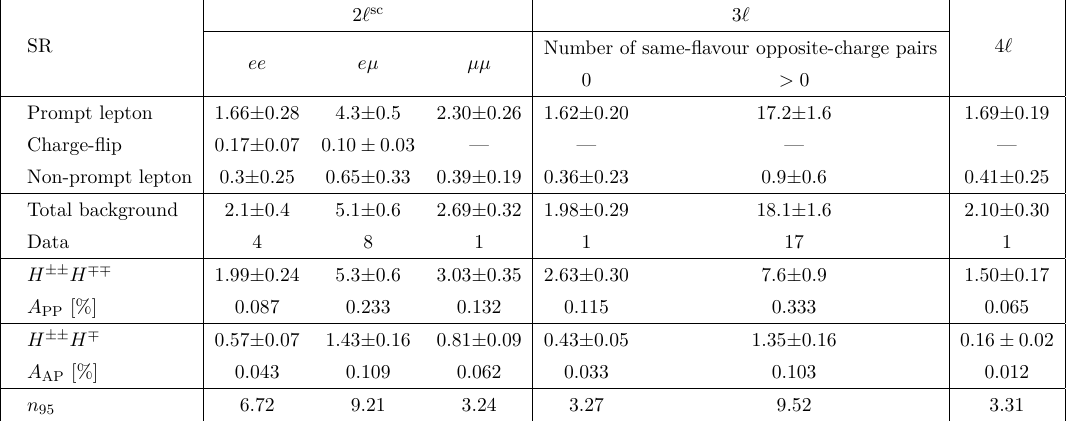
and A and the observed upper PP AP , are also presented. 95